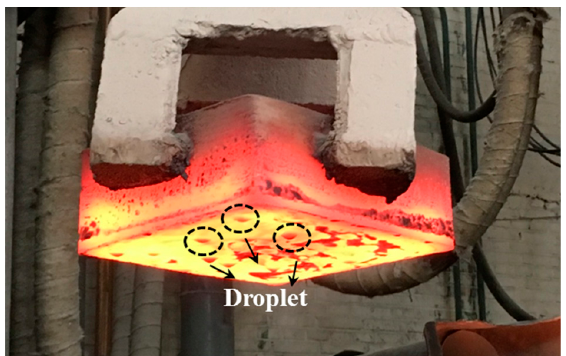
Figure 3. Morphology of the electrode tip.